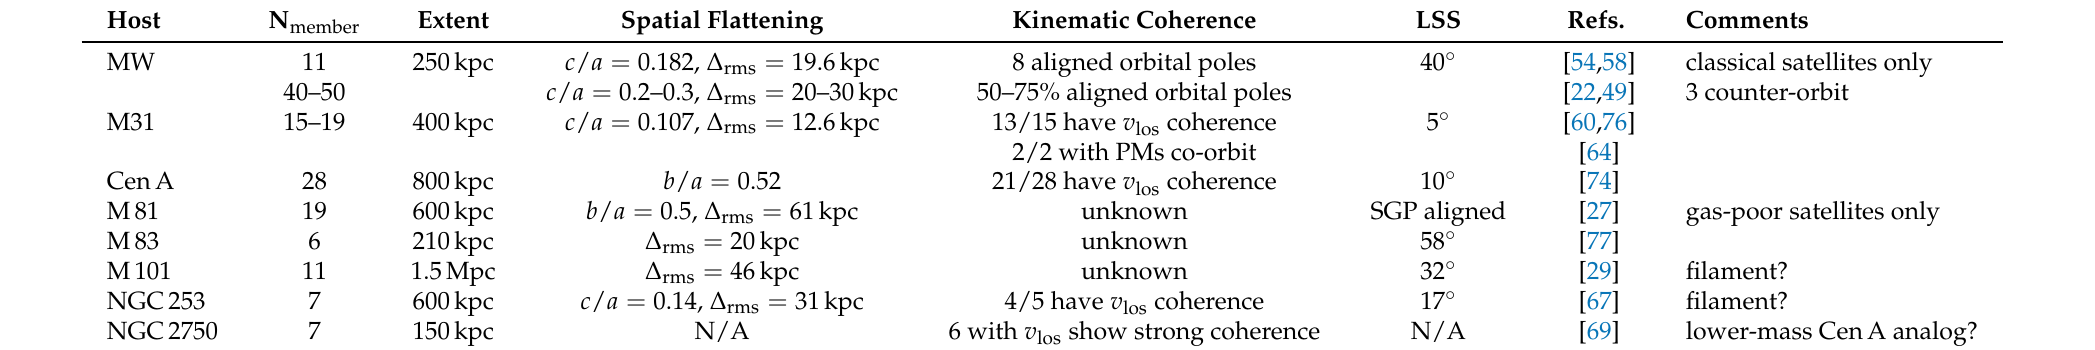
Table 1. Proposed Planes of Satellite Galaxies in the Local Volume. Flattening is either given as absolute rms height ∆ rms , or as relative flattening as c / a (minor-to-major axis ratio) or b / a (on-sky minor-to-major axis ratio). LSS gives the alignment with the surrounding large-scale structure or super-galactic plane